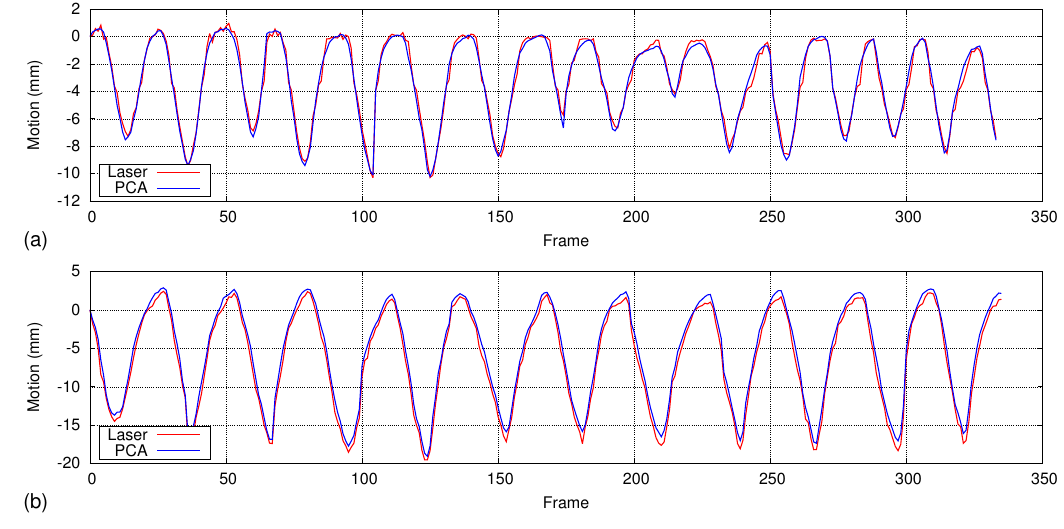
Figure 16. Motion comparison graphs generated for a regular respiratory patterns over a longer duration (350 frames). The first 100 frames are used for PCA, and only the first principal component is used as the motion model. All frames are then used for accuracy analysis. Higher accuracy could be achieved even though only the first PC is used for reconstruction. Graphs ( a , b ) show the motion comparison results of two different datasets.